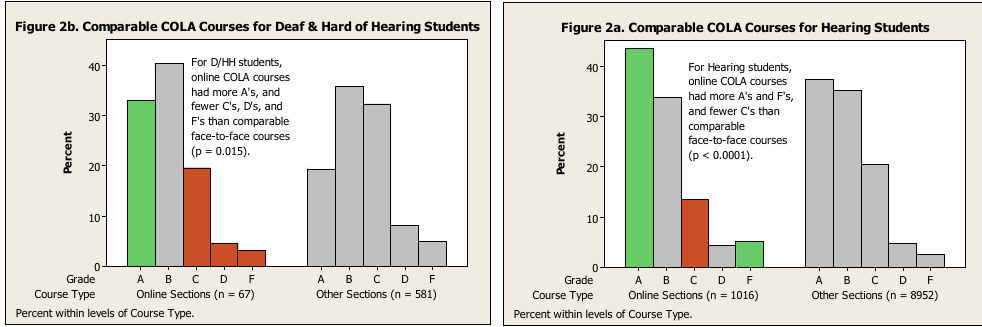
Figure 2b. Comparable COLA Courses for Deaf & Hard of Hearing Students